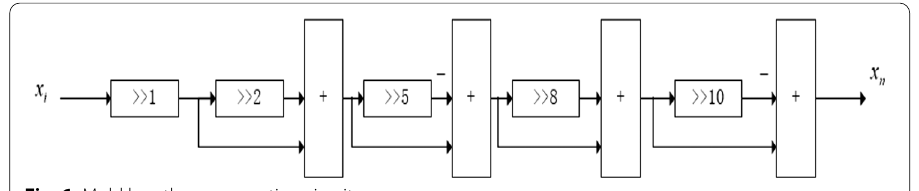
Fig. 6 Mold length compensation